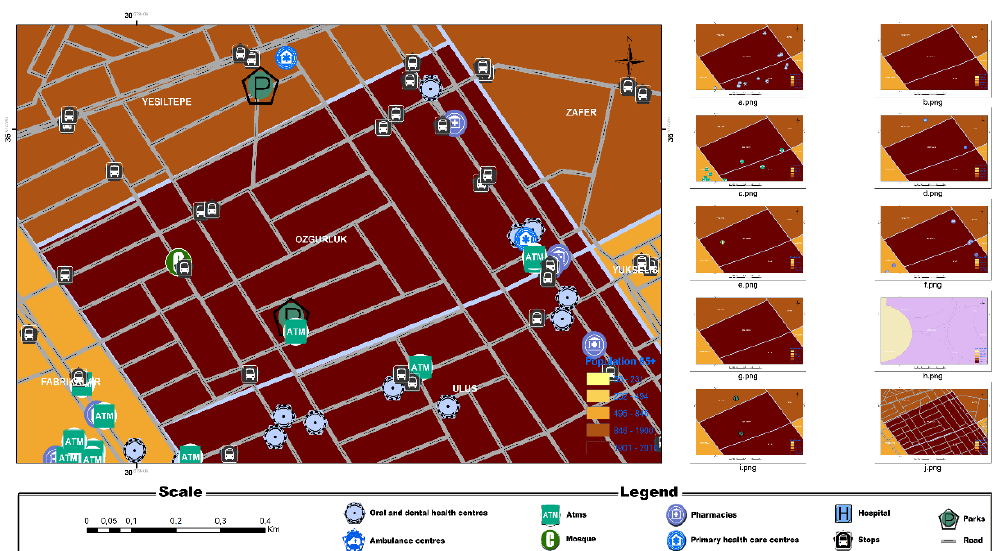
Figure 6. Location and density map of selected criteria in Özgürlük